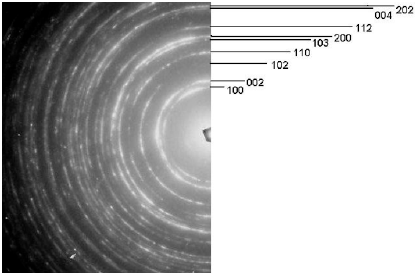
Figure 7. Diffraction spectrum for α -Ti with higher intensities of the diffraction lines for {100} planes.